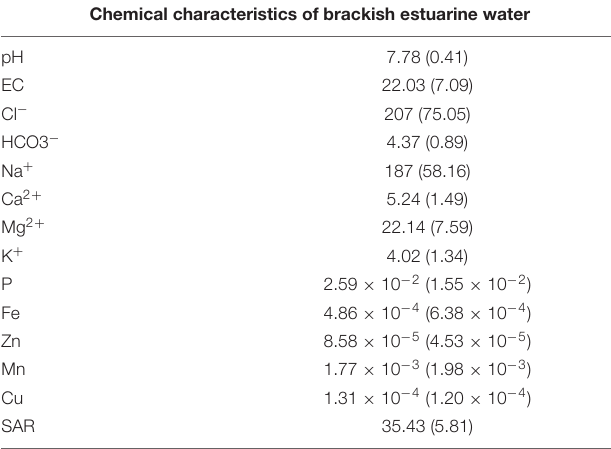
TABLE 2 | Chemical characteristics of irrigation water (mean ± SD, n = 3) collected in Sobralinho, in the Municipal Council of Vila Franca de Xira, west